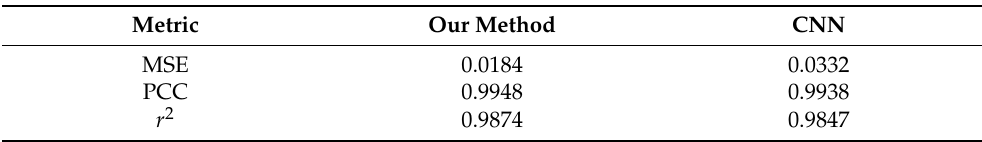
Figure 5. Predicted seismic data section, impedance sections, true impedance section and residual sections on Marmousi2 model: ( a ) the seismic data section predicted by the forward model F ∗ ; ( b ) the true impedance; ( c ) the impedance predicted by conventional Convolutional Neural Network (CNN) method; ( d ) the impedance predicted by the proposed method; ( e ) the residual of ( c ) and ( b ); ( f )the residual of ( d ) and ( b ). The red arrows mark the abnormal gas charged sand channel and the complex structures in the model. Table 1. Performance metrics of our method on Marmousi2 model compared with the conventional CNN